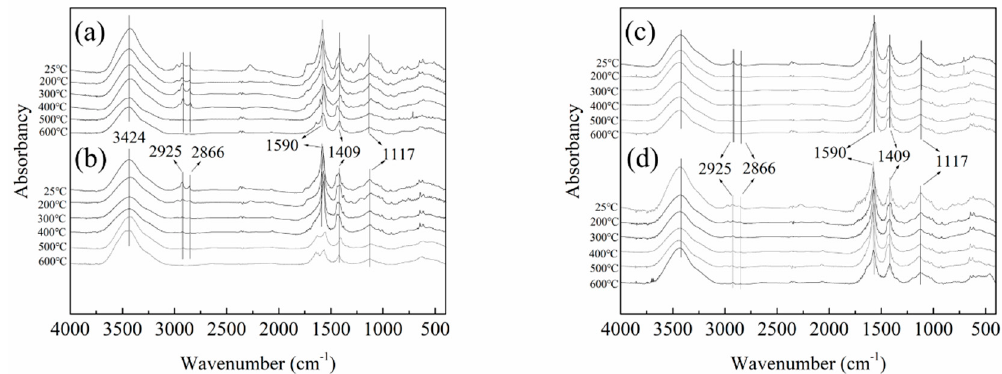
Figure 4. Fourier transform infrared (FT-IR) spectra of the RPUF specimens obtained at specific temperatures: ( a ) RPUF; ( b ) FRPU; ( c ) FRPU/GO; and ( d ) FRPU/fGO.